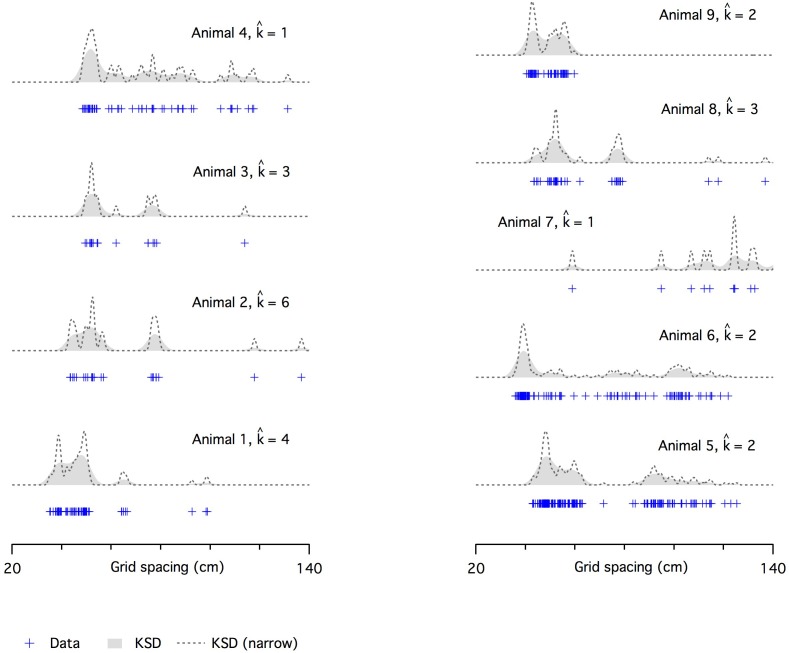
Evaluation of modularity of grid firing using an adapted gap statistic algorithm.Examples of grid spacing for individual neurons (crosses) from different mice. Kernel smoothed densities (KSDs) were generated with either a wide (solid gray) or a narrow (dashed lines) kernel. The number of modes estimated using the modified gap statistic algorithm is ≥ 2 for all but one animal (animal 4) with n ≥ 20 (animals 3 and 7 have < 20 recorded cells). We did not have location information for animal 2.